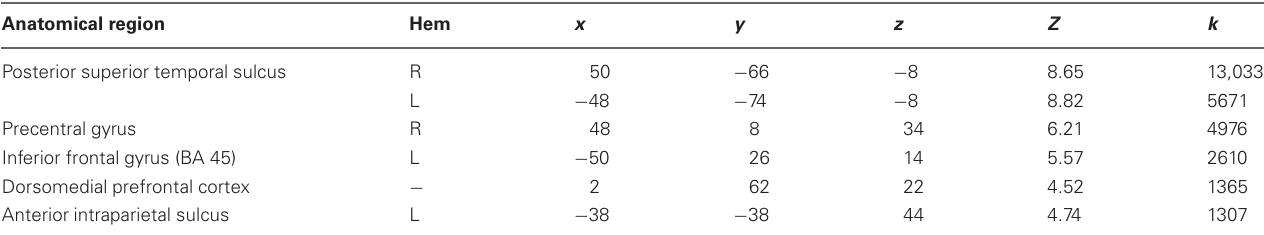
Table 1 | MNI coordinates and response intensity of brain regions displaying a significant response to Animate > Random stimuli p < 0 . 05 (corrected).